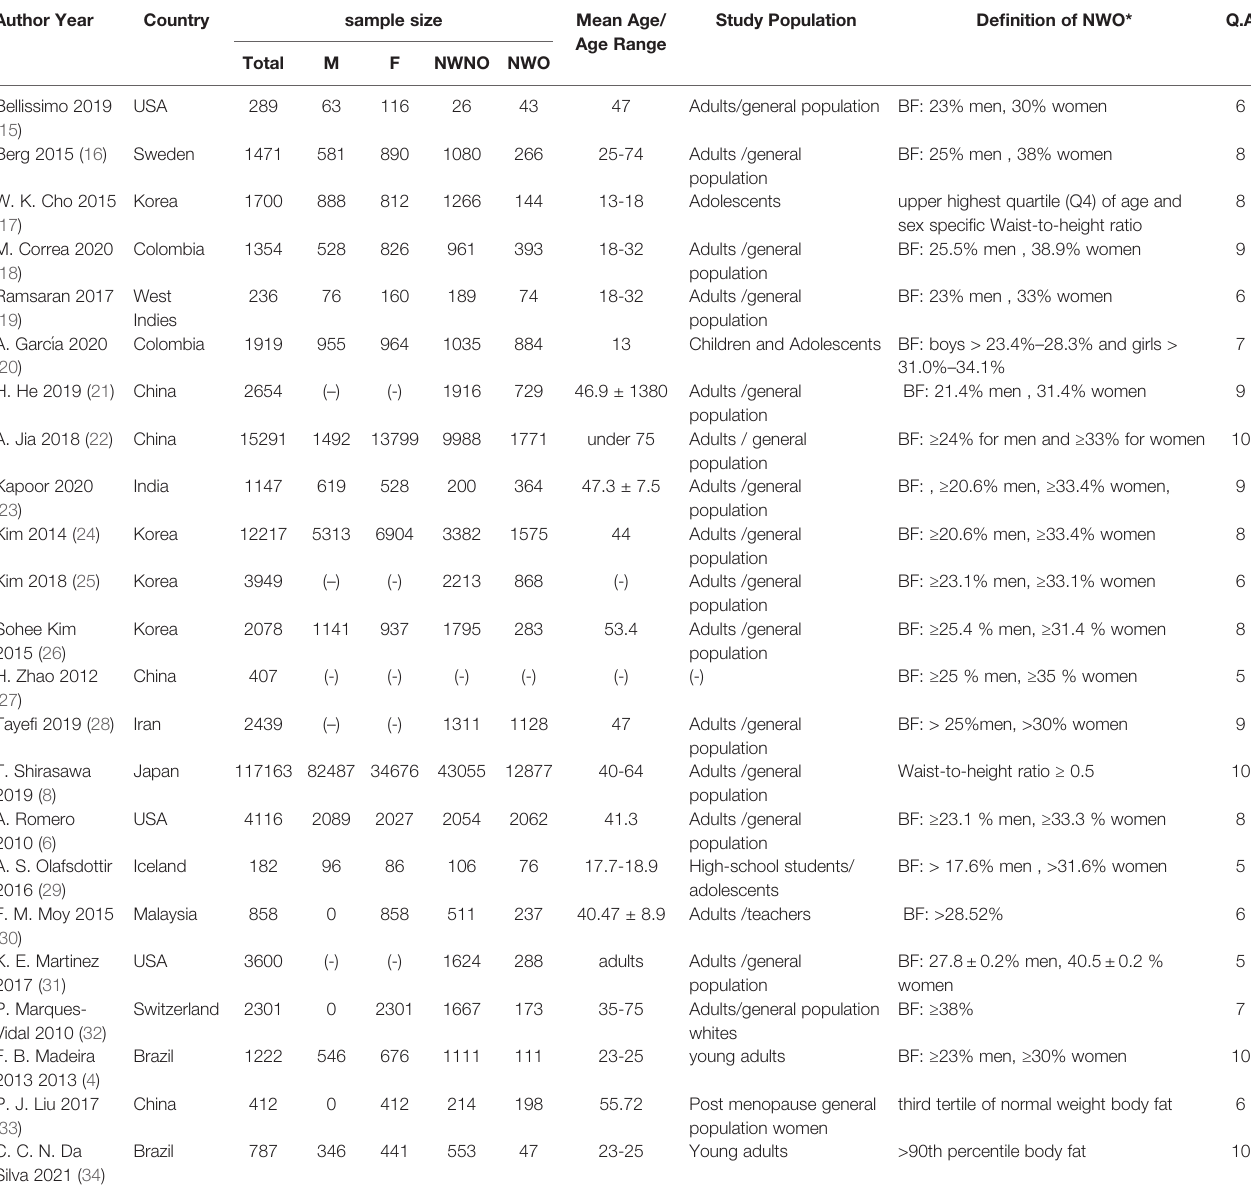
TABLE 1 | General Characteristics of included studies for association of NWO with